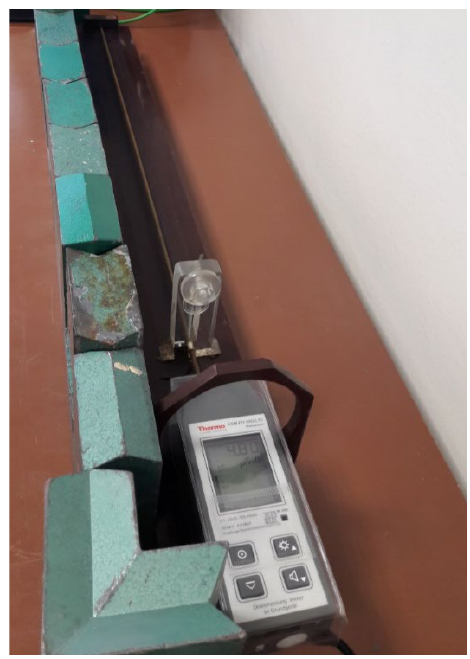
Fig. 4. The experimental workspace